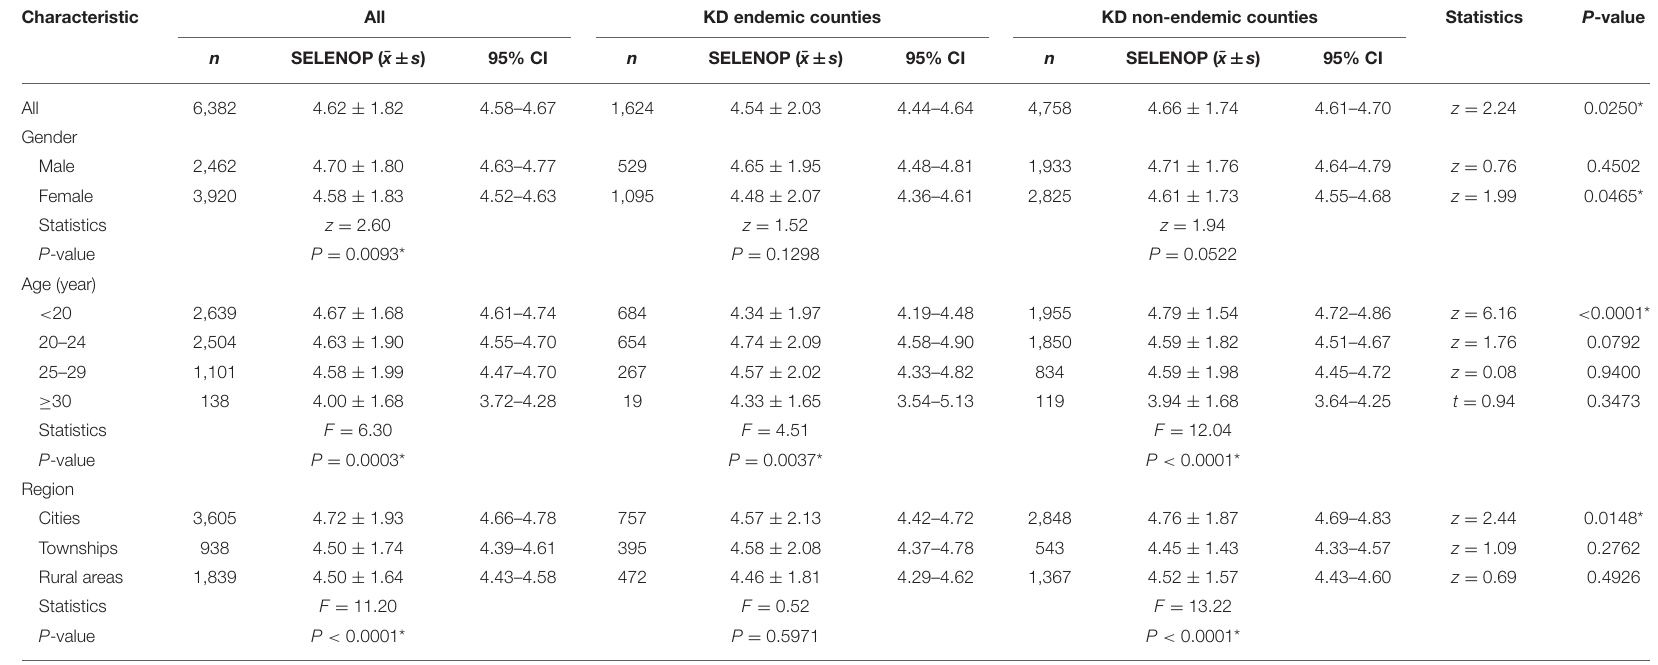
TABLE 1 | Serum SELENOP levels by demographic characteristics and association with KD endemic area ( µ g/mL). Characteristic All KD endemic